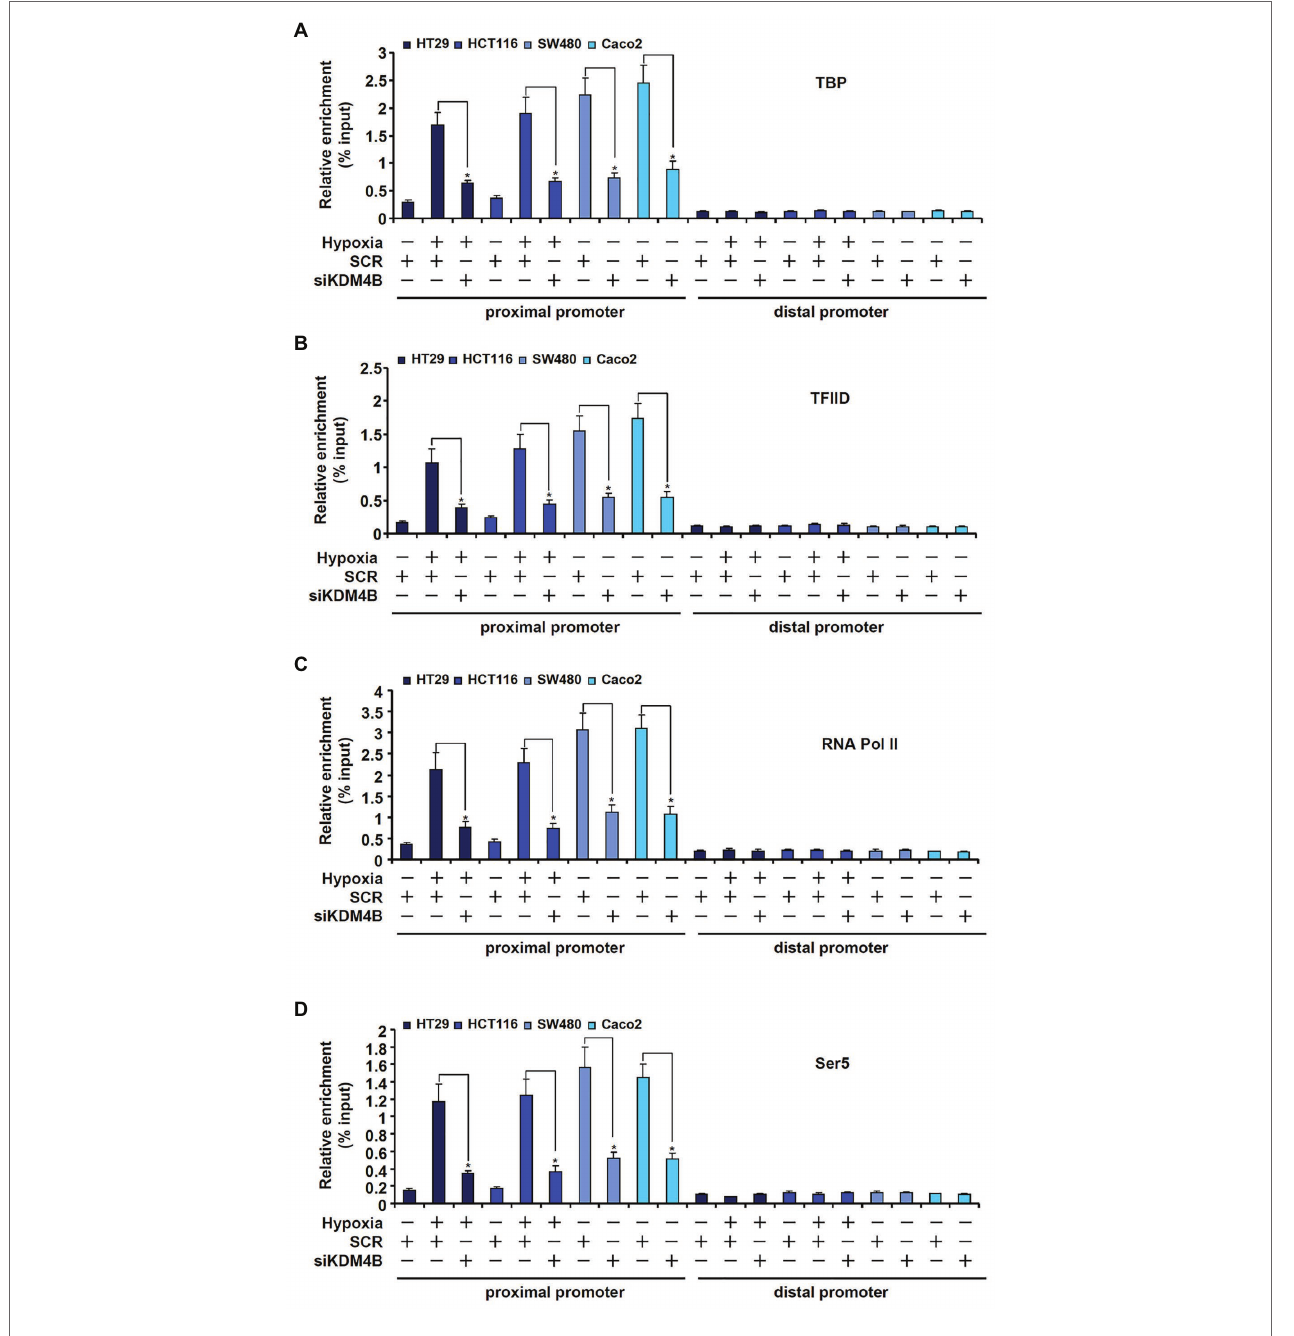
FIGURE 4 | KDM4B facilitates the assembly of the pre-initiation complex (PIC) on the TCL promoter. (A–D) HT29 and HCT116 cells were transfected with indicated siRNAs followed by exposure to hypoxia. ChIP assays were performed with anti-TBP (A) , anti-TFIID (B) , anti-RNA Pol II (C) , and anti-Ser5 (D)